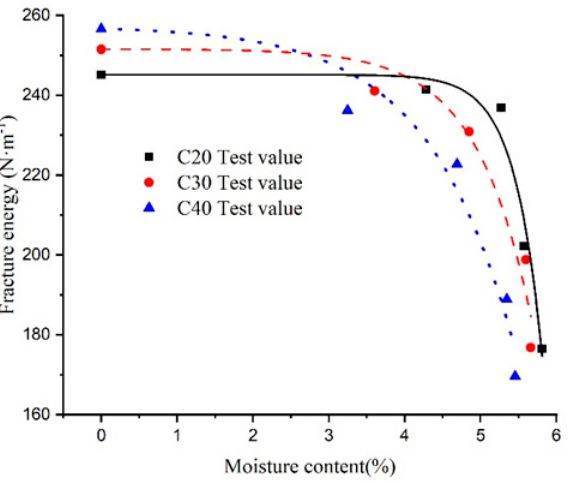
Figure 8. Fracture energy curve of concrete with different moisture content.